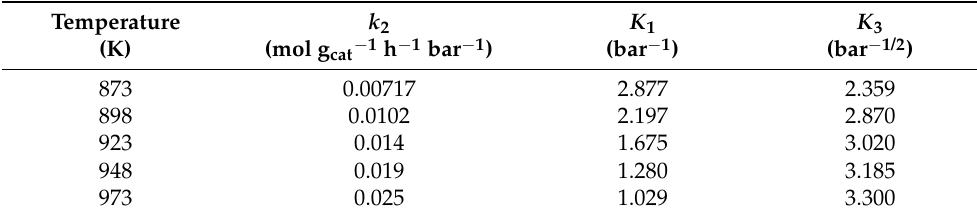
Table 1. Reaction rate and equilibrium constants used in the present